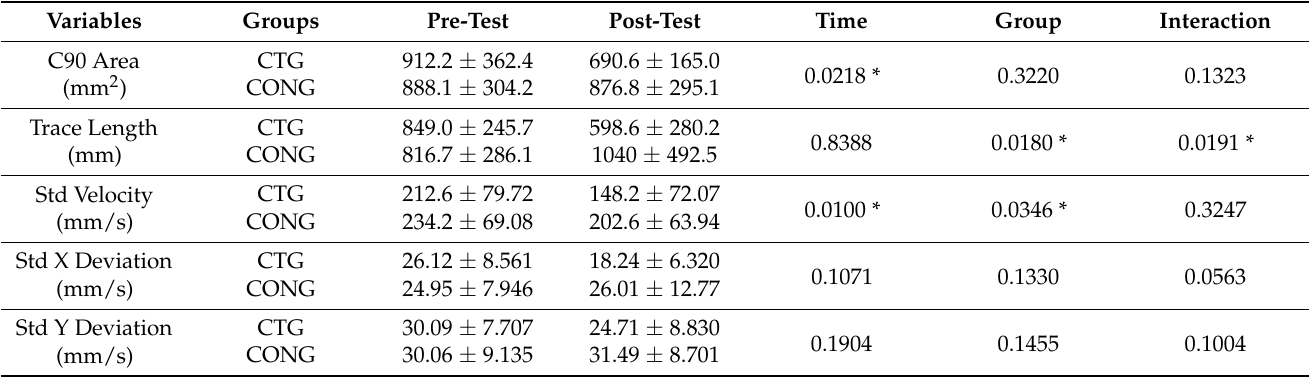
Table 10. Comparative analysis of various indicators of static balance before and after the experiment with eyes closed and right foot standing (REC).